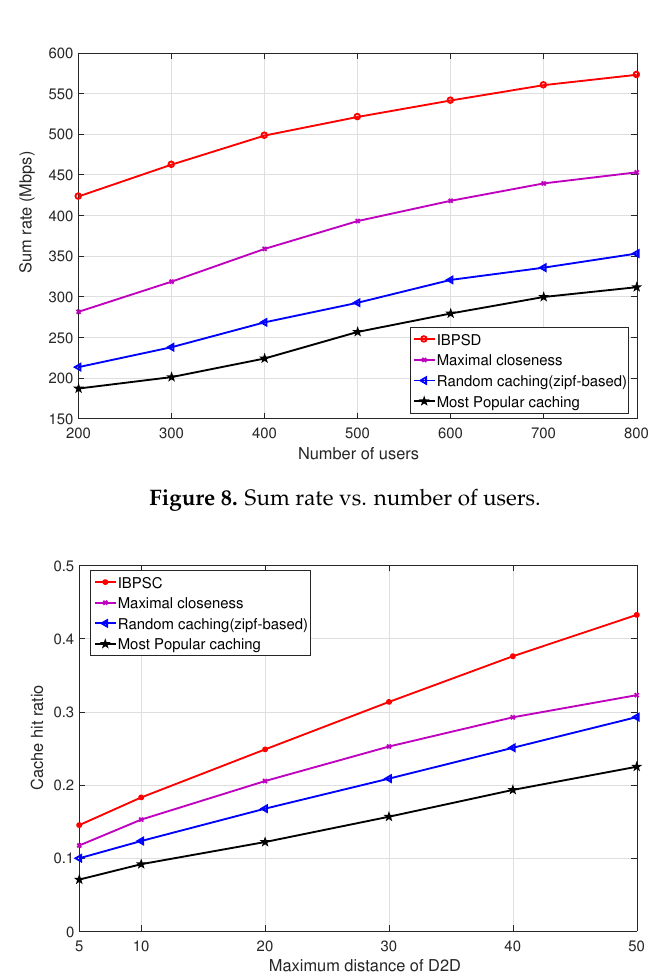
Figure 7. Cache hit ratio vs. number of users.